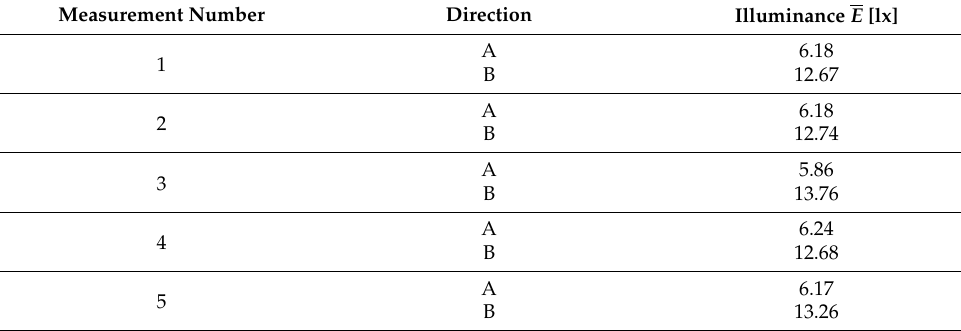
Table A5. Example of the results for measurement field No.